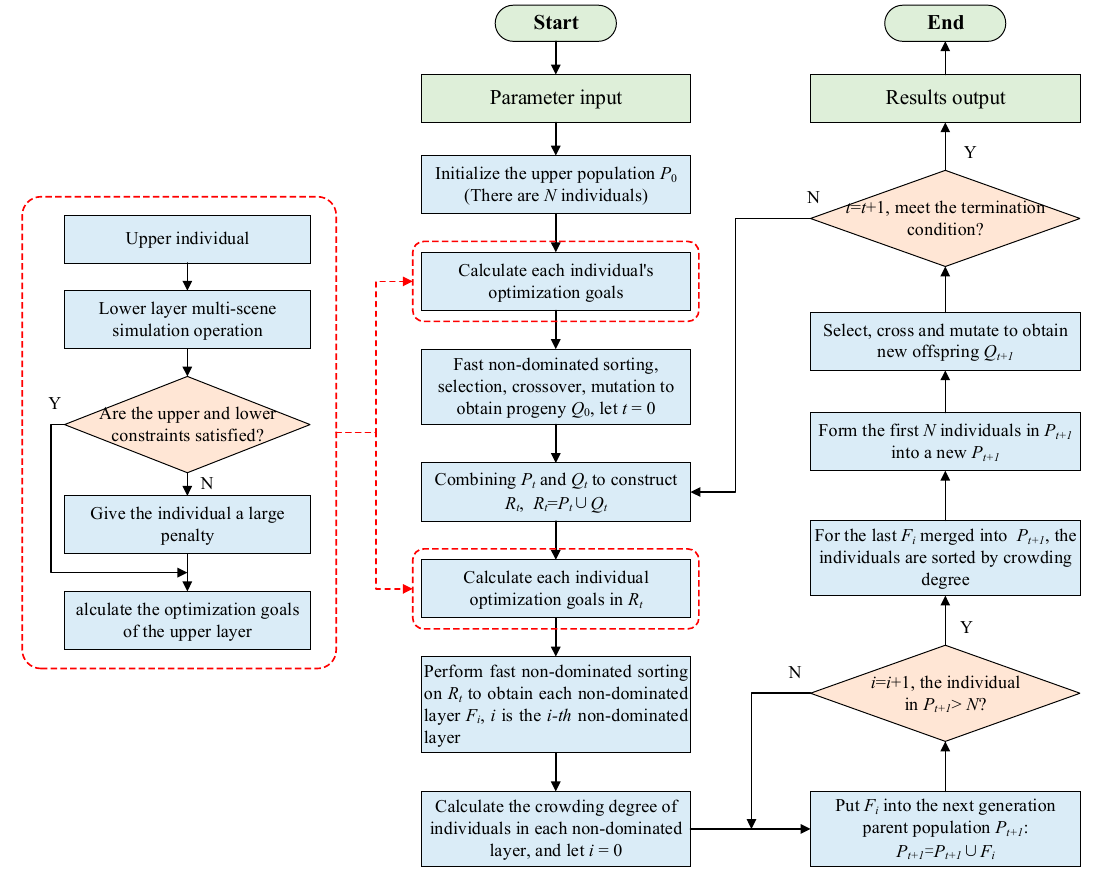
Figure 2. Model solution flowchart.